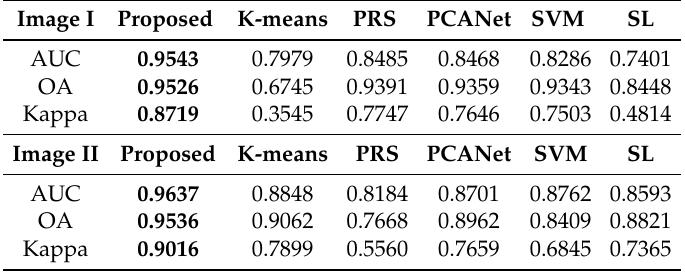
Table 1. The detection performance of different methods on Images I and II from the Landsat 8 dataset. AUC: area under the curve; Kappa: kappa coefficient; OA: overall accuracy. The bold fonts indicate the best